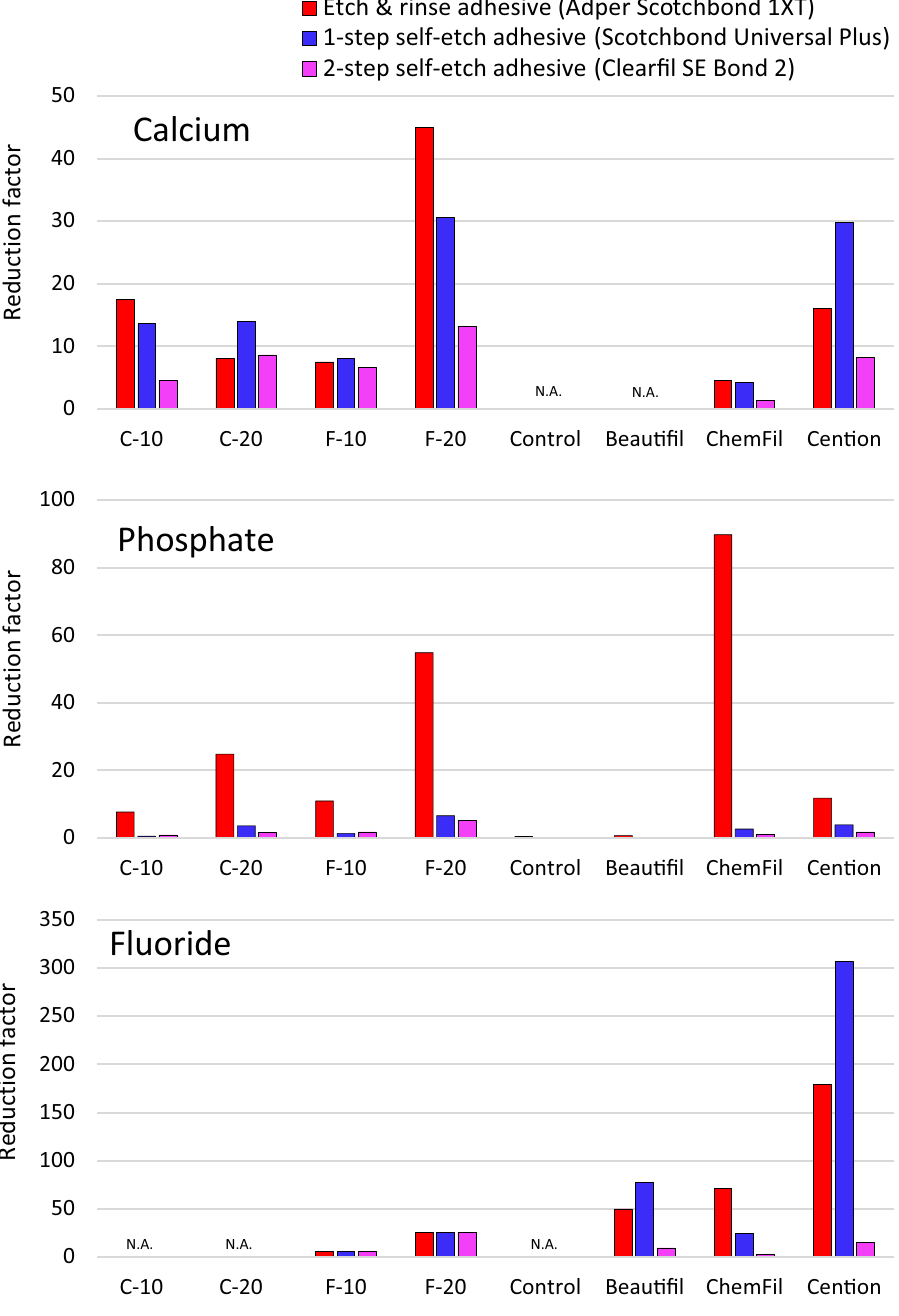
Figure 6. Reduction factors for calcium, phosphate, and fluoride ions calculated by diving the concentrations of uncoated specimens by the corresponding concentrations of adhesive-coated